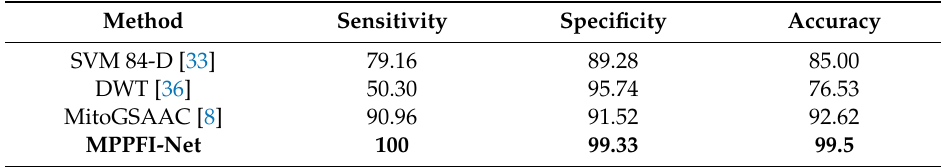
Table 5. MPPIF-NET comparative analysis with other models on the MPD